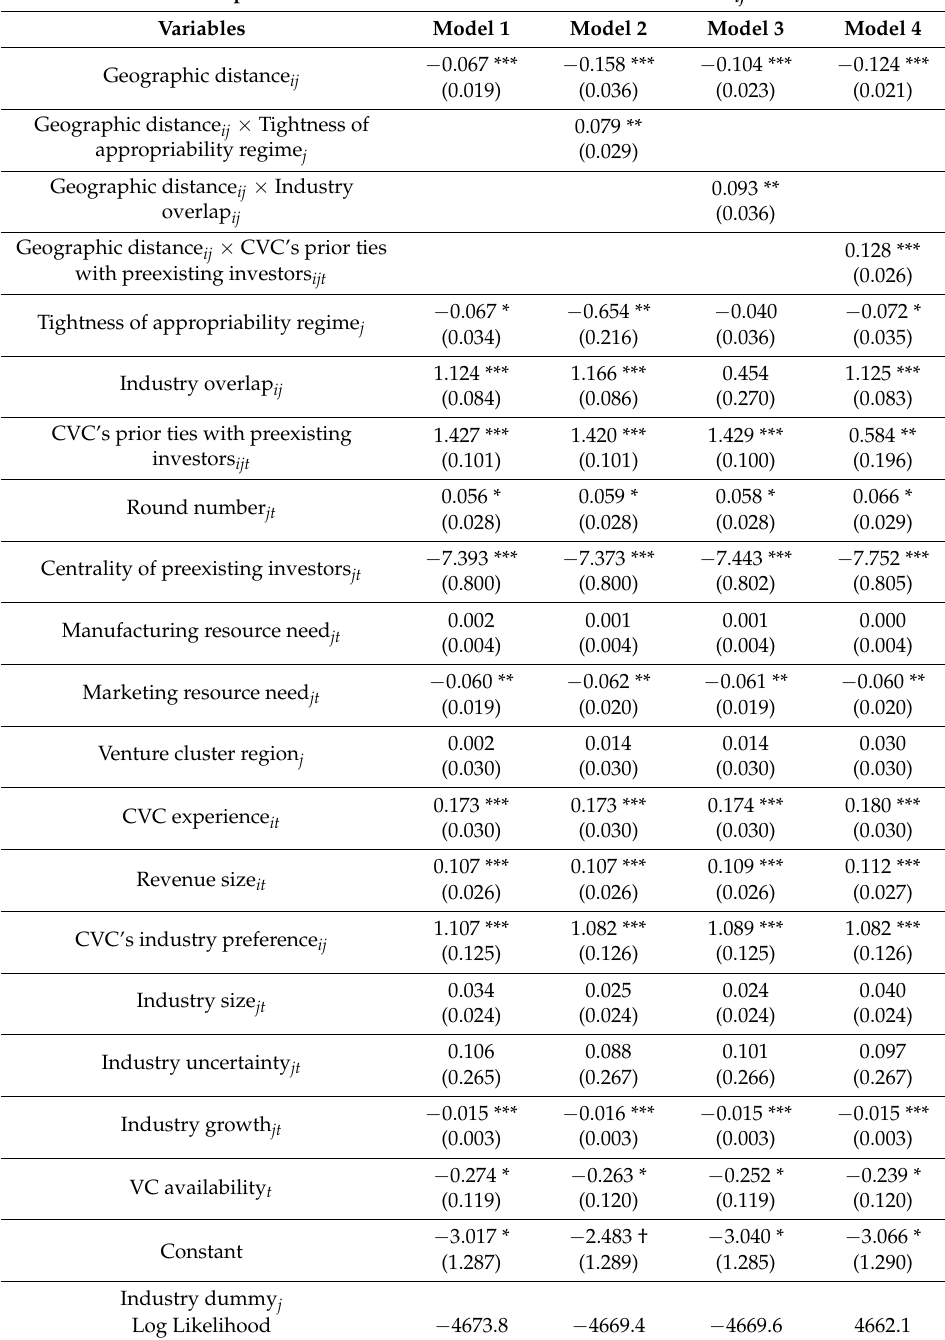
Table 1. Logit regression of the likelihood of CVC